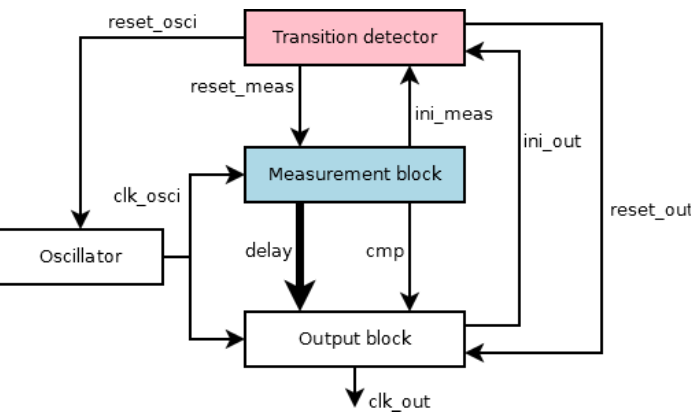
Figure 2. Architecture of the sensor at block